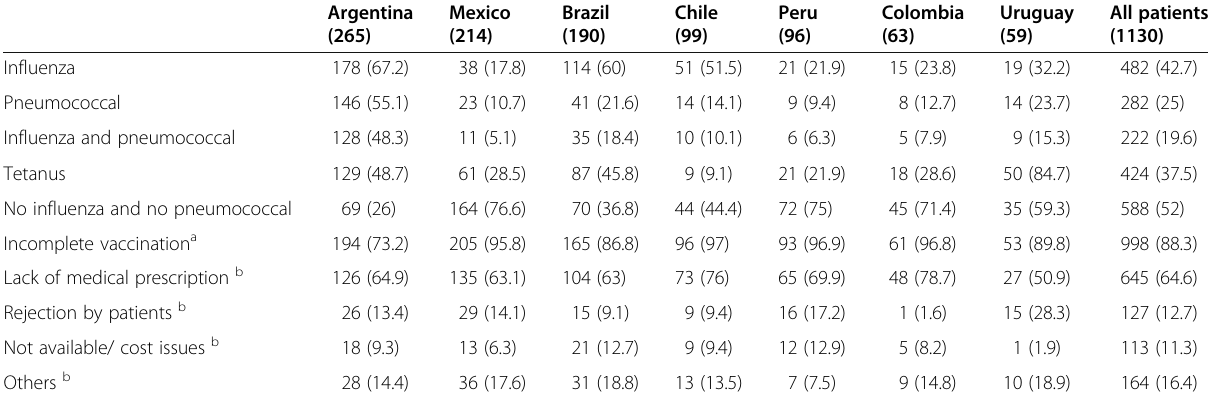
Table 2 Vaccine coverage and reasons for non-vaccination of Latin American patients* Argentina